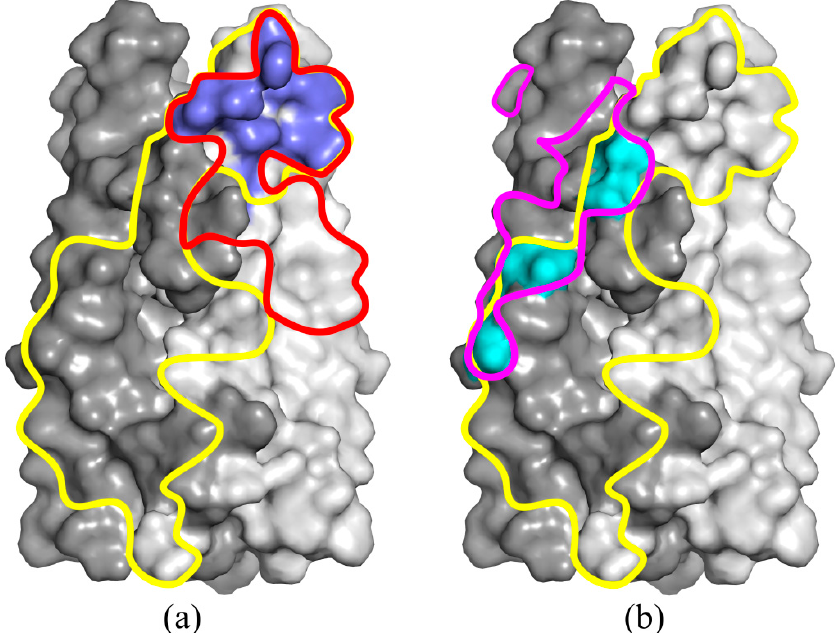
Figure 8. Surfaces of IL-17A monomers are shown in shades of grey. The yellow outline shows contacts with the IL-17RA receptor. ( a ) The main contacts of the anti-IL-17A-76 with IL-17A are shown in a red outline. The dark blue color shows the intersection between the anti-IL-17A-76 and IL-17RA contacts with IL-17A. ( b ) The crystal contact region is depicted with a crimson outline. The contact intersections area is shown in cyan.